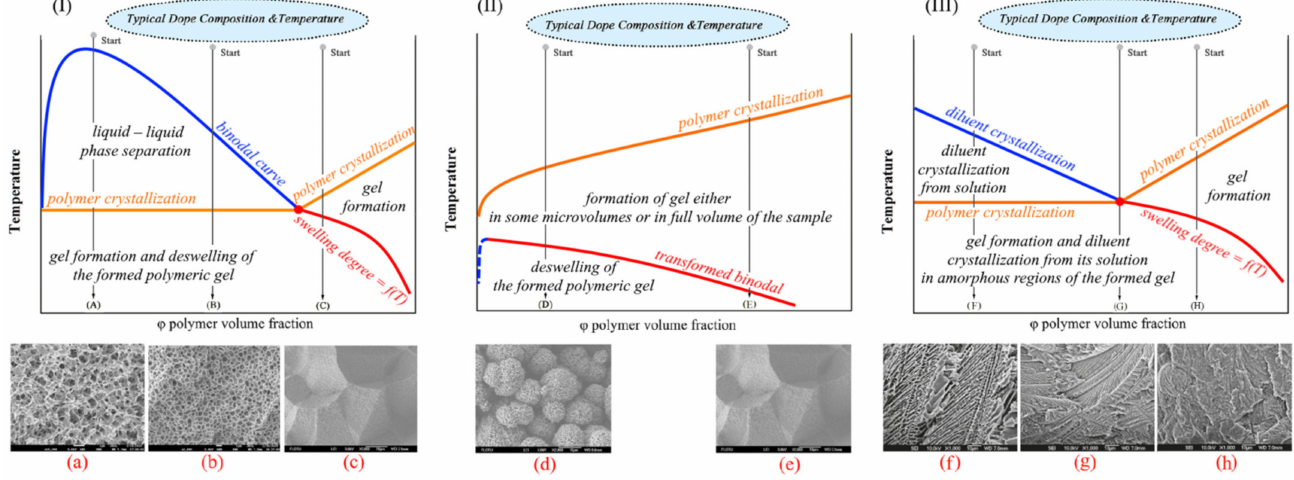
Figure 5. Schematic phase diagrams for the SC polymer mixtures with ( I ) poor and ( II ) good liquid solvents and ( III ) a low MW crystalline substance constructed taking into account the swelling ability of SC polymers and typical structures formed as a result of the TIPS of various mixtures. Subfigures correspond to the typical morphology of capillary-porous bodies formed due to cooling of the homogeneous mixtures by paths ( a ) A, ( b ) B, ( c ) C, ( d ) D, ( e ) E, ( f ) F, ( g ) G and ( h )